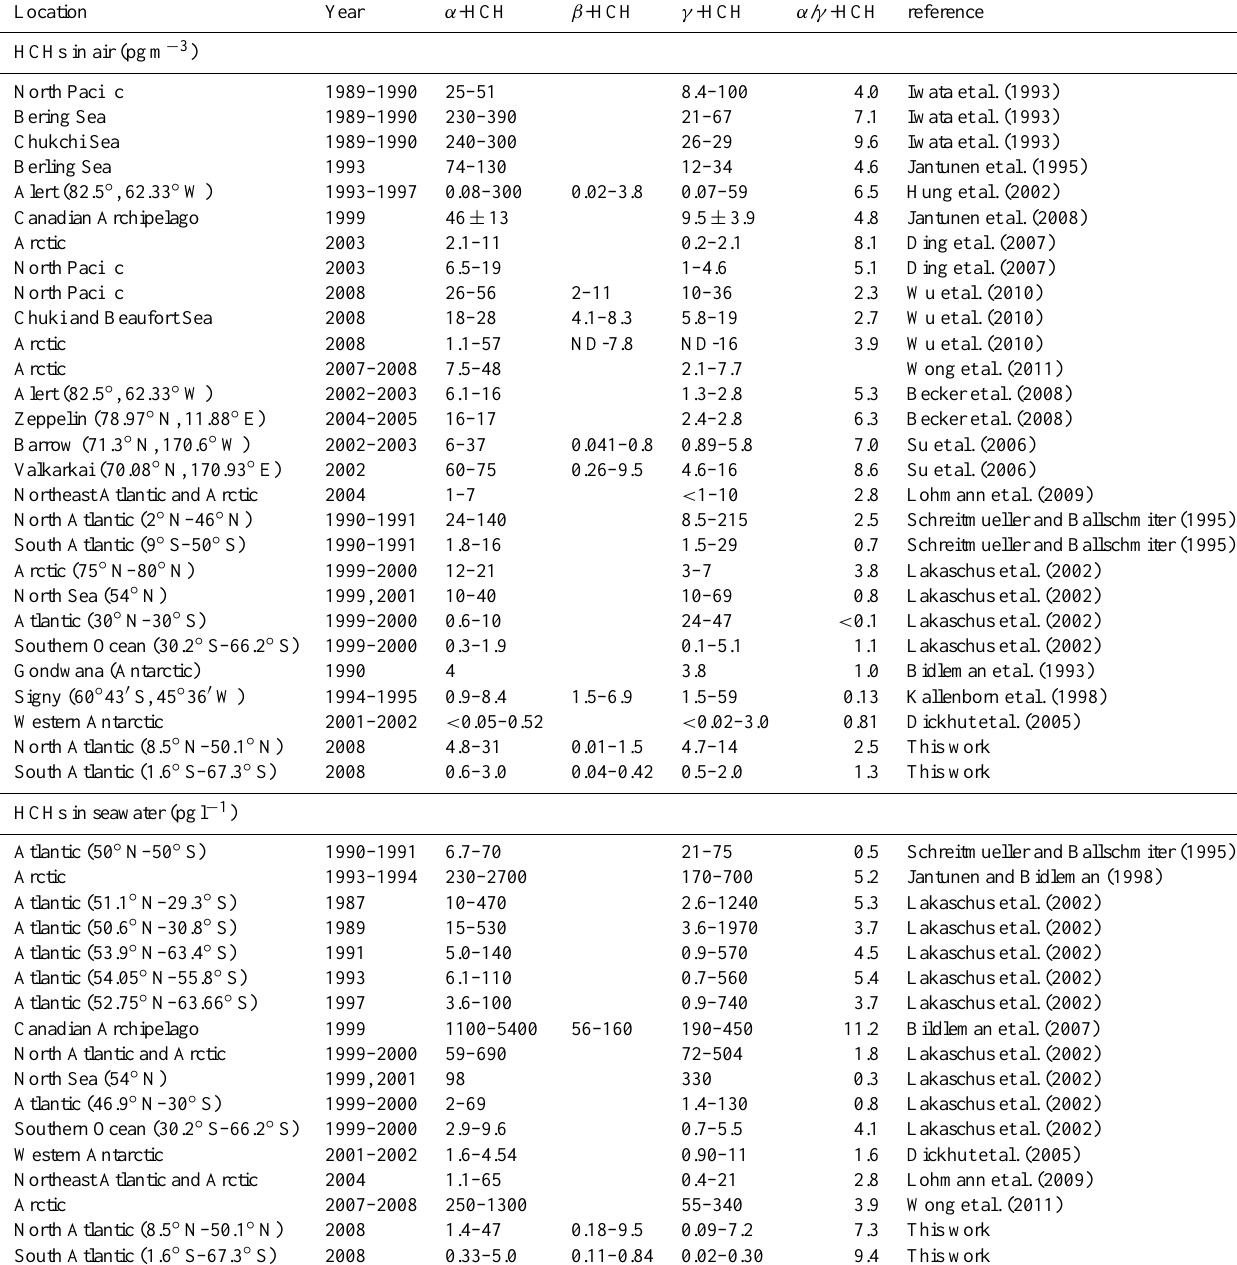
Table 3. Comparison of HCH concentrations measured in the present study with previous data in seawater and air of the oceans and Polar